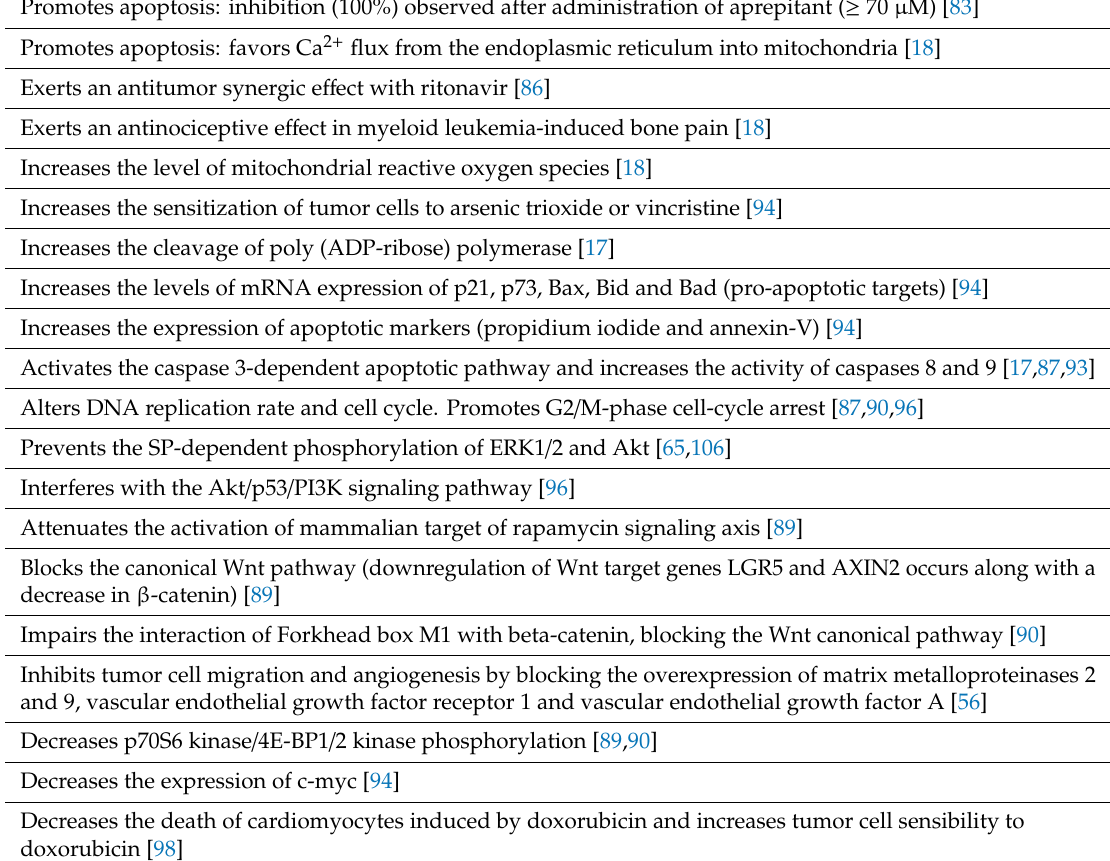
Table 2. E ff ects of aprepitant on cancer